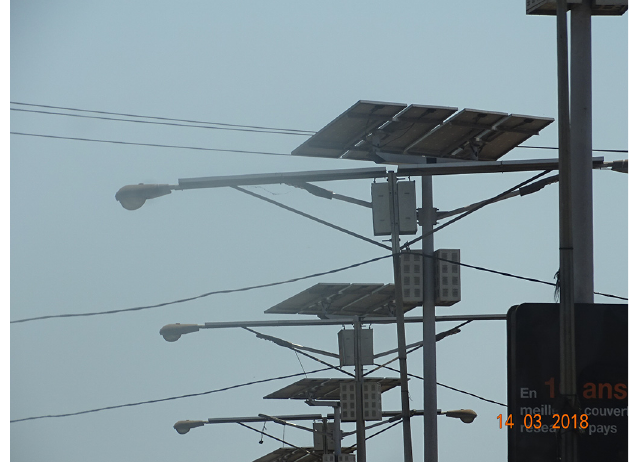
Fig. 10. Two different solar projects on the same street with grid available Conakry (cid:1) Guinea (Photo J. Kenfack).